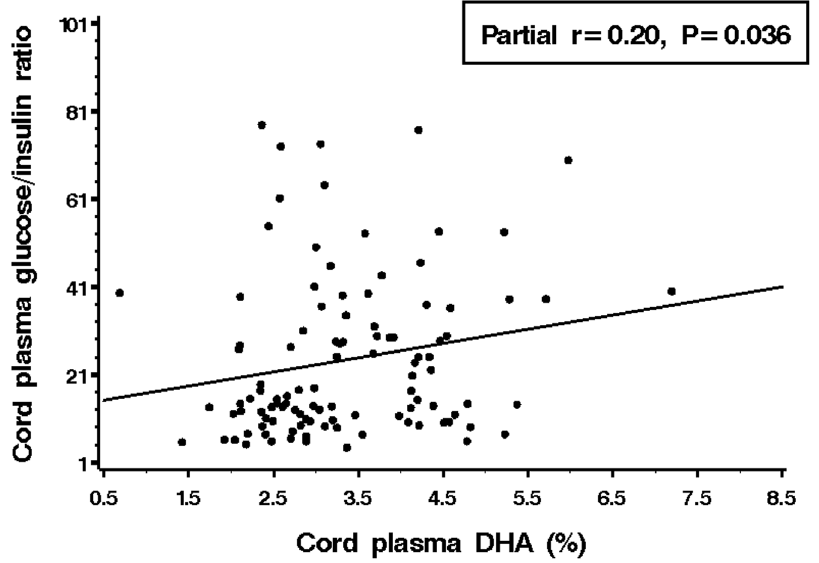
Figure 1. Positive correlation between cord plasma DHA and glucose-to-insulin ratio. doi:10.1371/journal.pone.0085054.g001 PLOS ONE |